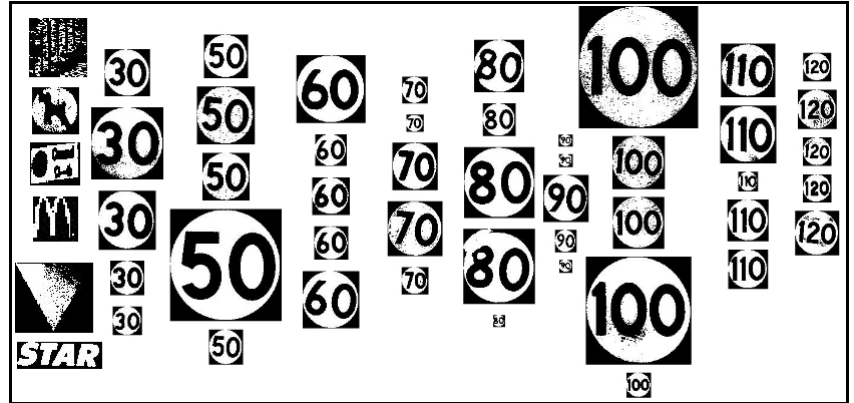
Figure 4. The Training